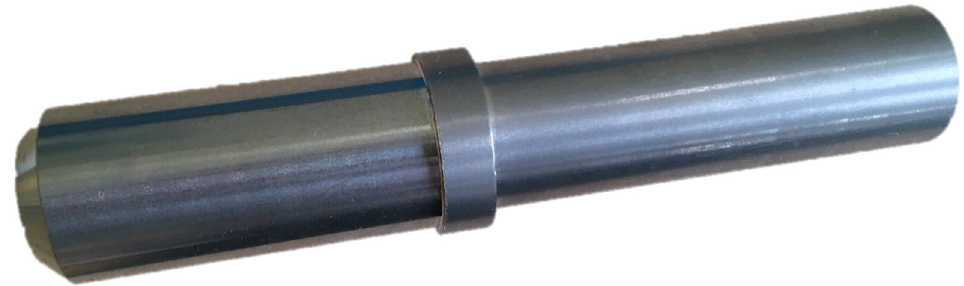
Figure 17. The part after machining with the support of technological parameters selection.